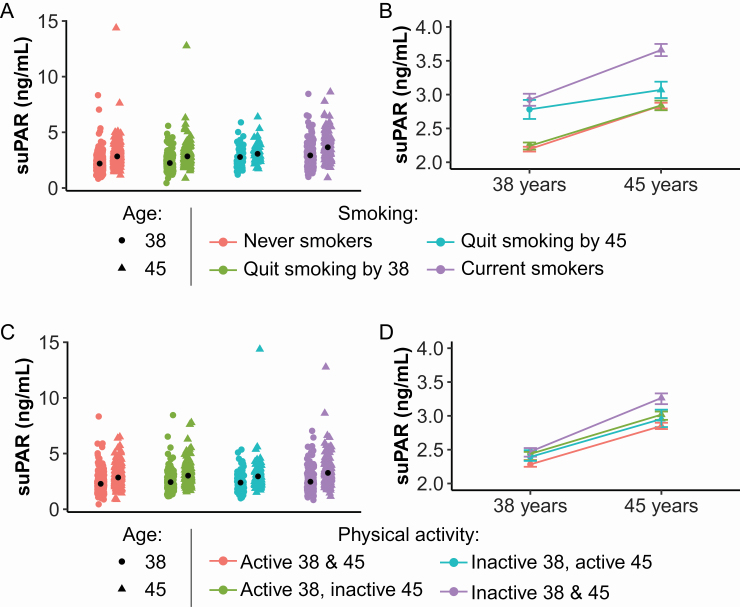
Change in health habits is associated with change in suPAR levels. suPAR levels by smoking (A and B, n = 842) and sports/leisure-time physical activity (C and D, n = 840) categories at ages 38 and 45 years. For smoking (A and B), participants were categorized as those who never smoked (n = 424); those who were former smokers but quit before age 38 (n = 203); those who were former smokers but quit between age 38 and age 45 (n = 52); and those who were still smoking at age 45 (n = 163). For physical activity (C and D), participants were categorized as those who were physically active (ie, achieved the minimum recommended dosage of physical activity of 500 METs per week) at both ages 38 and 45 (n = 311); those who were physically active at age 38 but inactive (ie, did not achieve 500 METs per week) at age 45 (n = 221); those who were inactive at age 38 but physically active at age 45 (n = 197); and those who were physically inactive at both ages 38 and 45 (n = 111). Panels A and C show scatterplots of suPAR levels at age 38 and 45 years with black dots indicating mean suPAR. Panels B and D show mean suPAR at age 38 and 45 years with error bars indicating standard error. Note: The 2 individuals with suPAR > 10 ng/mL both had kidney disease and were undergoing dialysis. Controls for kidney disease among other conditions did not alter the findings, see Table 2. suPAR = soluble urokinase plasminogen activator receptor.